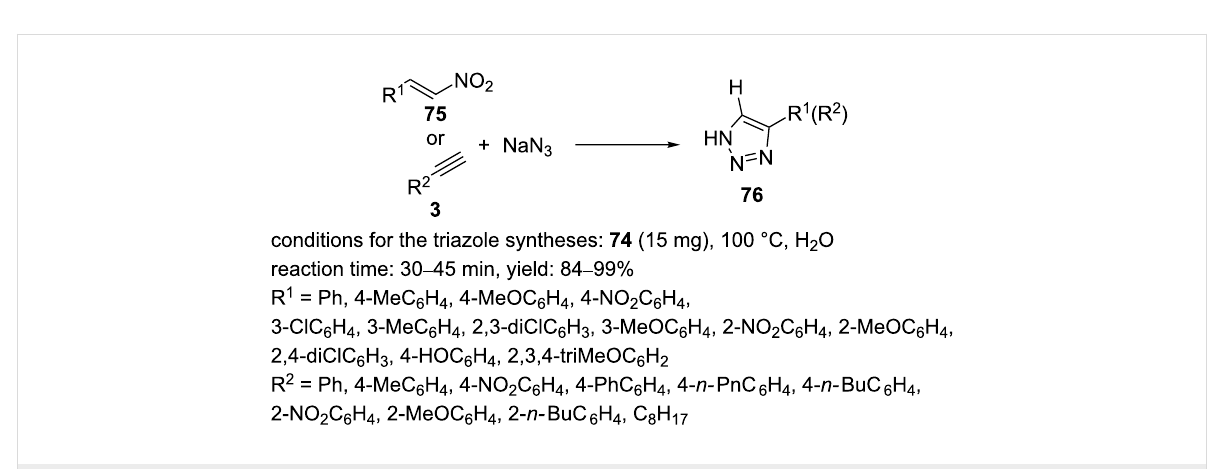
Scheme 13: Synthetic route to, and chemical structure of the catalyst 74 .